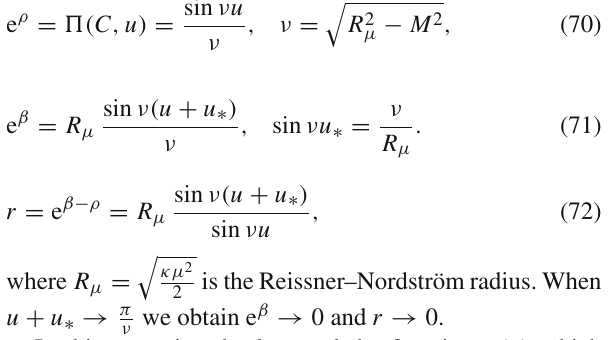
Fig. 1 Behavior of the electric and axion fields described by exact solutions(61),(64).Theuppercurveistheplotofthenormalizedelectric field E , where E 0 = Q γ , as the function of the normalized radial 2 μ 2 E 0 variable r γ | μ | . The lower curve relates to the normalized axion field γμ (φ − φ ) . For the presented plots we have chosen | Q | = | μ 0 Q